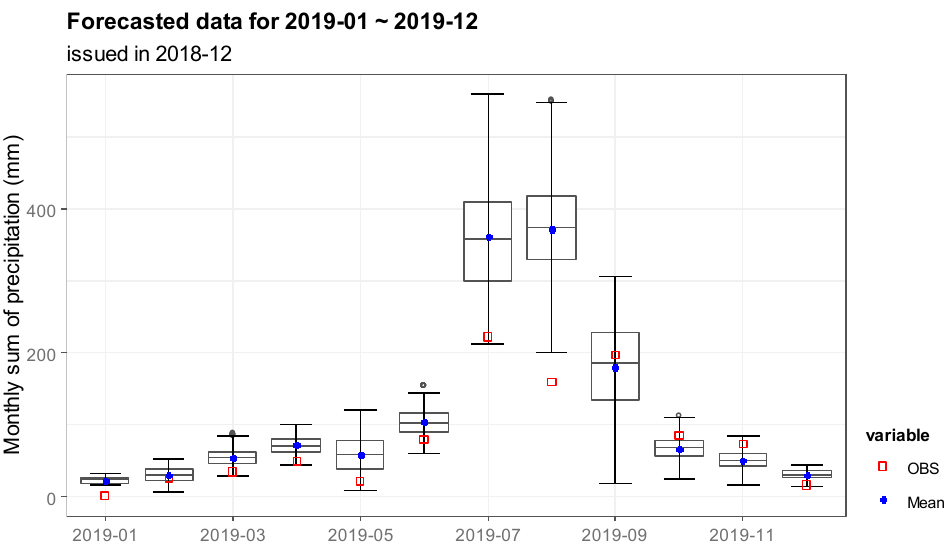
Figure 10. Results of monthly precipitation forecasting from January to December 2019.